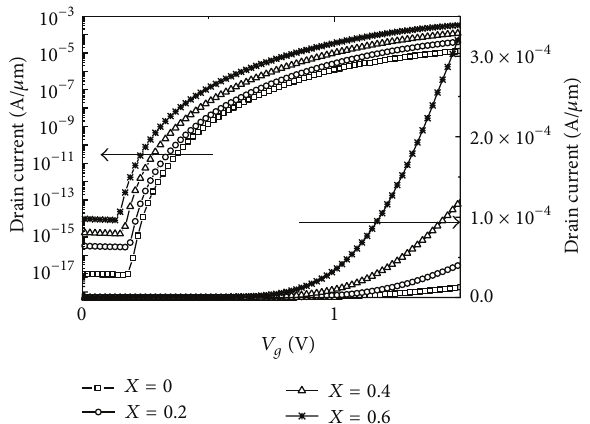
Figure 3: Simulated transfer characteristics of FD-SSOI TFETs for varying strain 𝑋 .